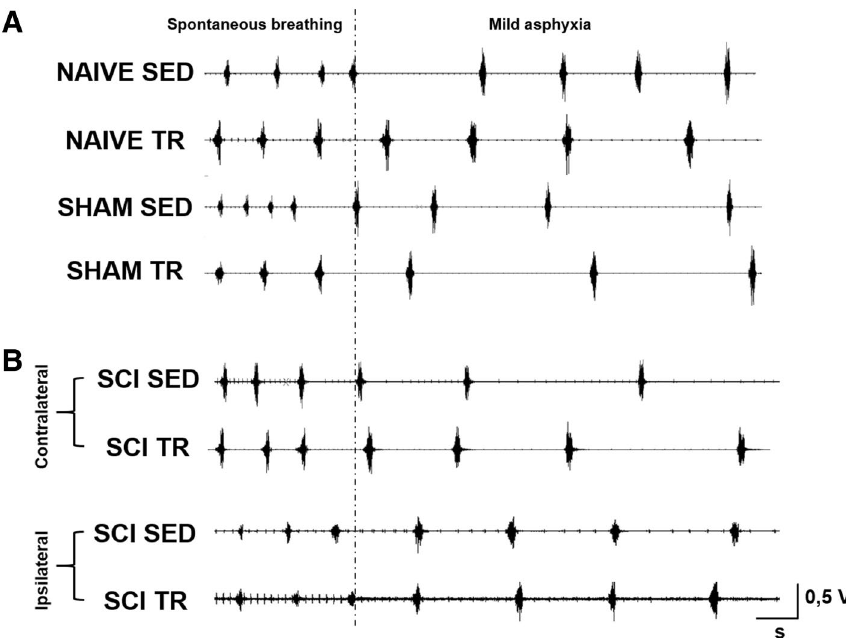
Figure 5. Diaphragm activity at 51 days following a C2 hemisection. ( A ) Representative traces of diaphragm raw electromyography for uninjured animals: NAIVE and SHAM groups (SED and TR) and ( B ) injured (contralateral diaphragm and ipsilateral diaphragm) animals: SCI groups (SED and